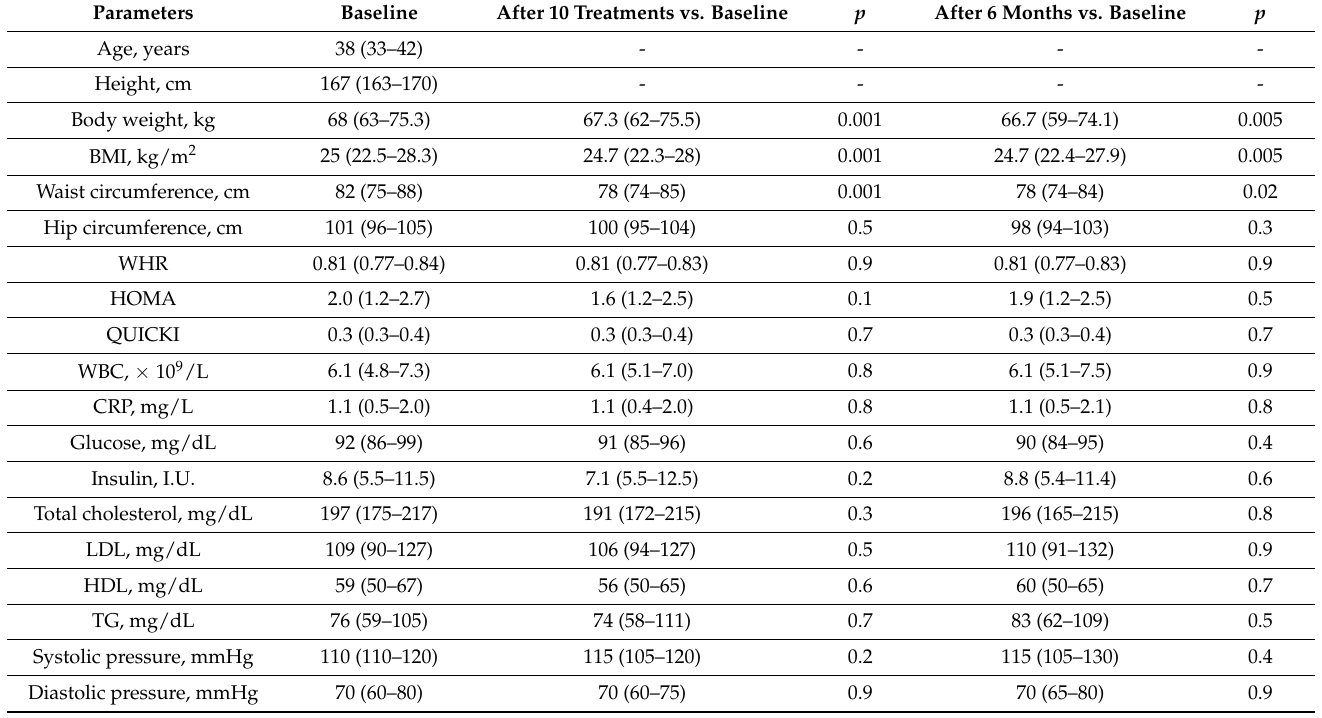
Table 1. The clinical, anthropometric and biochemical characteristics of the study population and the short and long-term effects of all interventions applied for an adipose tissue reduction.